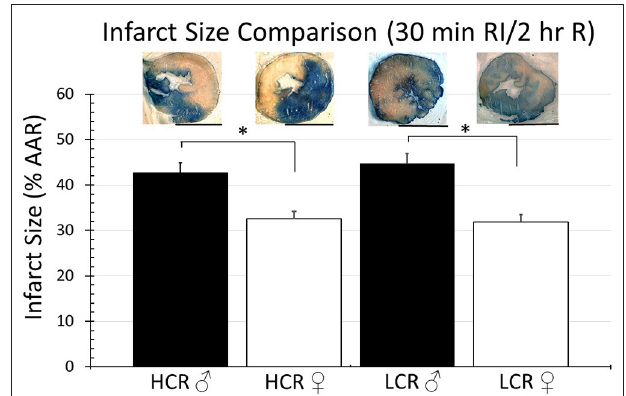
FIGURE 2 | Comparison of the average infarction size normalized to area at risk (%AAR) between HCR male/female and LCR male/female rats after 30min ischemia and 2h reperfusion using an in situ regional ischemia (RI) model. Scale bars in images indicate 5mm. Significant differences were noted between sexes within each phenotype, but not between phenotypes for either sex (* p < 0.05 for the comparison